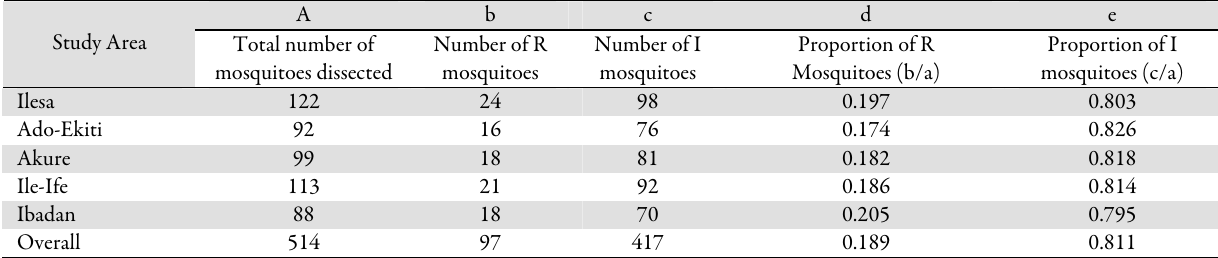
Tab. 2. Proportions of Refractory (R) and Infective (I) A. gambiae mosquitoes from the study